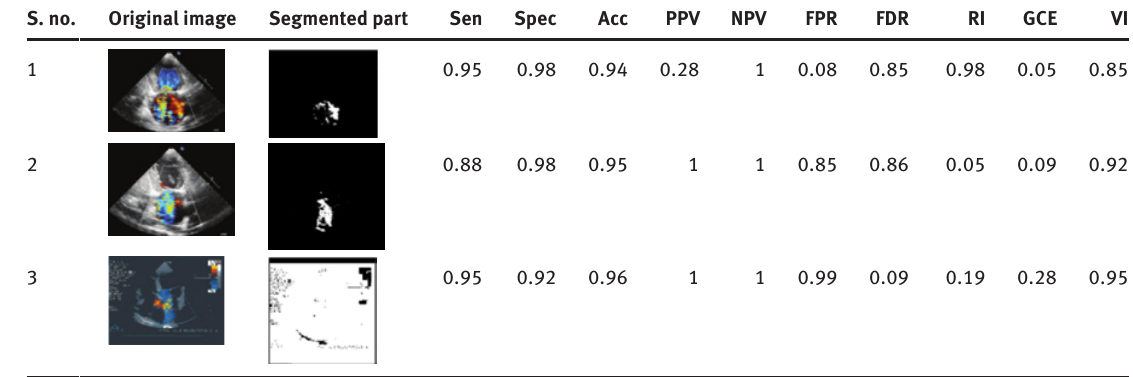
Table 1: Results for OHE-KHO. S. no.